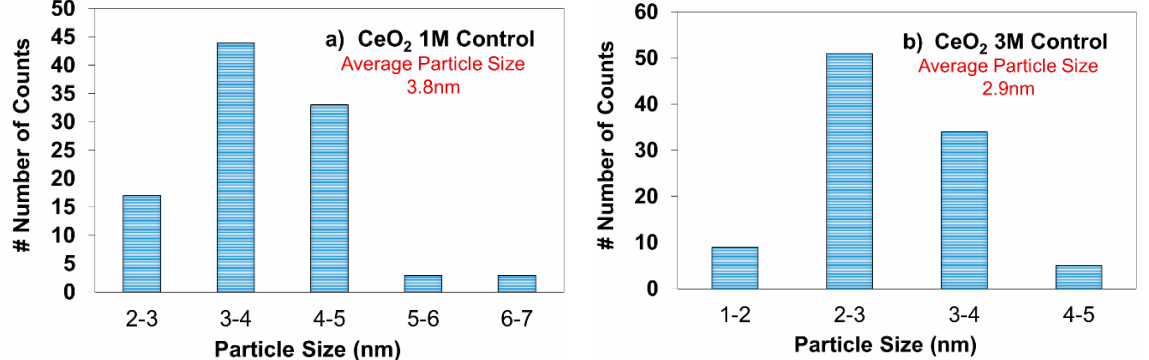
Figure 4. Particle size distribution histogram of Control CeO 2 sample: ( a ) 1 M; ( b ) 3